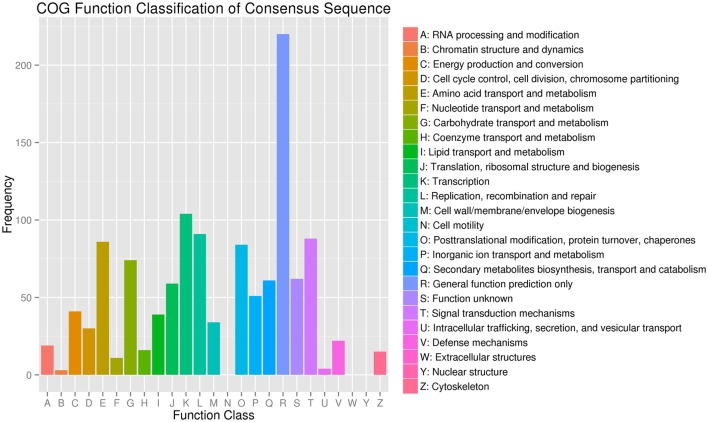
Clusters of Orthologous Groups (COG) functional classification of differentially expressed genes in JL-08 and JL-09 sprouts. The X axis represented different categories of COG in JL-08 and JL-09 sprouts. The Y axis is the frequency of different categories of COG.